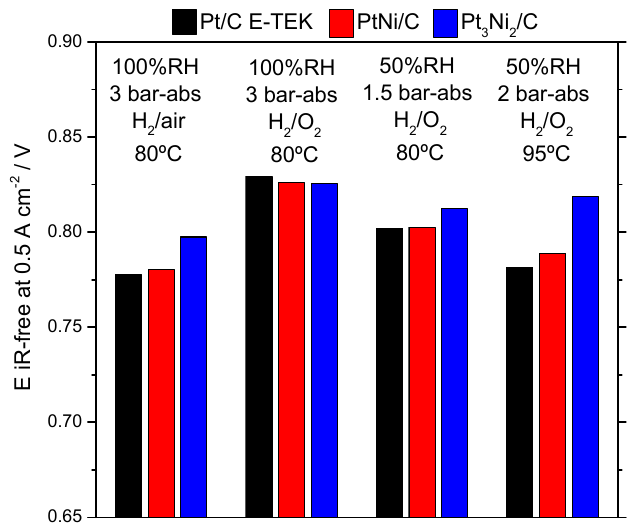
Figure 6. Cell potential (iR-free) at 0.5 A · cm − 2 for the MEAs equipped with PtNi/C (red), Pt 3 Ni 2 /C (blue) and Pt/C E-TEK (black) catalysts at the cathode under the operating conditions described. Accelerated degradation tests (ADTs), i.e., 15,000 step cycles (steps 0.6–1.2 V, cycle time 6 s, H 2 –N 2 ), were carried out for all catalysts at 80 °C, 100% R.H., 1.5 bar abs . A milder protocol, i.e., 0.6–0.9 V